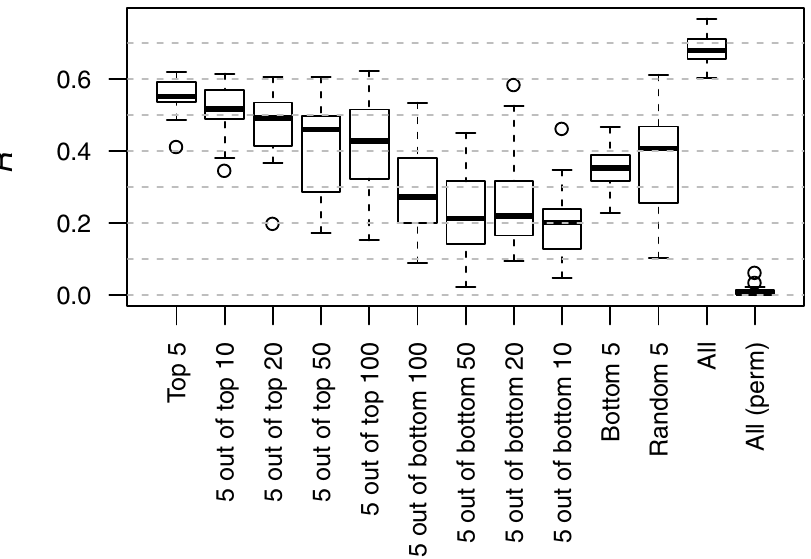
Fig 5. Predictability of hybrid performance based on subsets of the ranked parental features. Hybrid field performance was predicted using support vector regression models (SVR), each trained with different subsets of parental features, based on the median relative importance for predicting the metabolic inheritance patterns (mIPs). The models were trained with the top five parental features (‘Top 5’); five randomly drawn from the top 10/20/50/100 features (‘5 out of top 10’/‘5 out of top 20’/‘5 out of top 50’/‘5 out of top 100’, respectively); five randomly drawn from the bottom 10/20/50/100 features (‘5 out of bottom 10’/‘5 out of bottom 20’/‘5 out of bottom 50’/‘5 out of bottom 100’, respectively); bottom five parental features (‘Bottom 5’); five randomly drawn from all features (‘Random 5’). As the subsets comprise analytes ranked lower, predictability ( R 2 ) decreases. The full model (‘All’) exhibits the highest median R 2 whereas upon permutation of the values of hybrid performance (‘All (perm)’) the median R 2 is almost null.